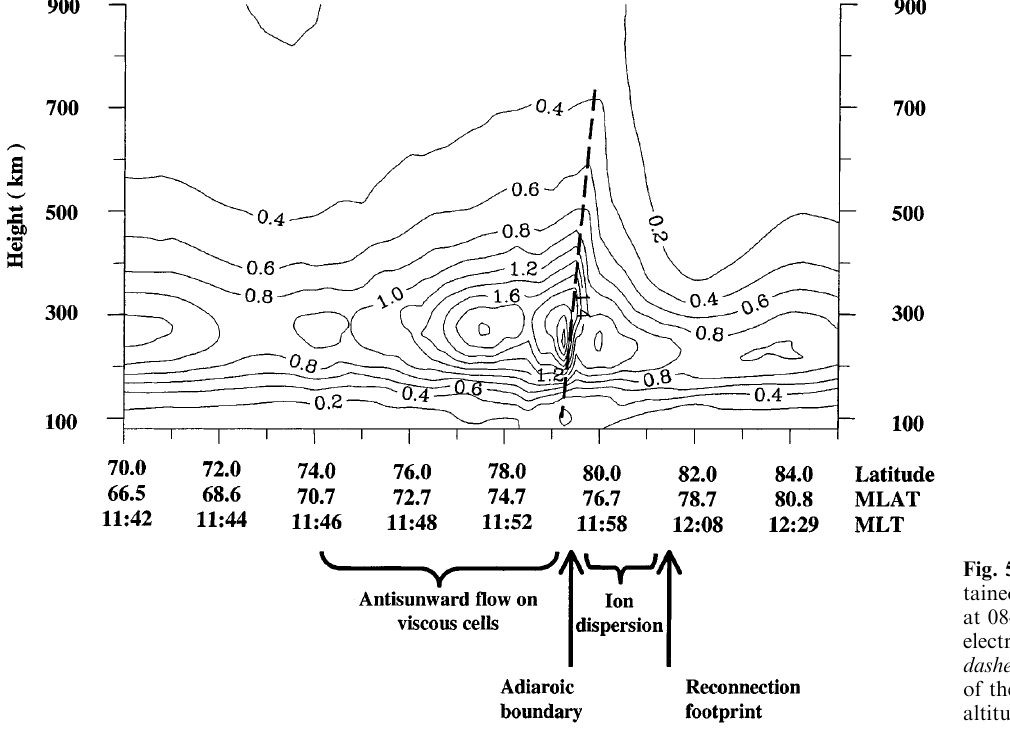
Fig. 5. Tomographic image ob- tained for the NIMS satellite pass at 0845 UT showing contours of electron density (m ) 3 ). The dashed line indicates the position of the field line that intersects an altitude of 250 km at 76.2 (cid:176) MLAT